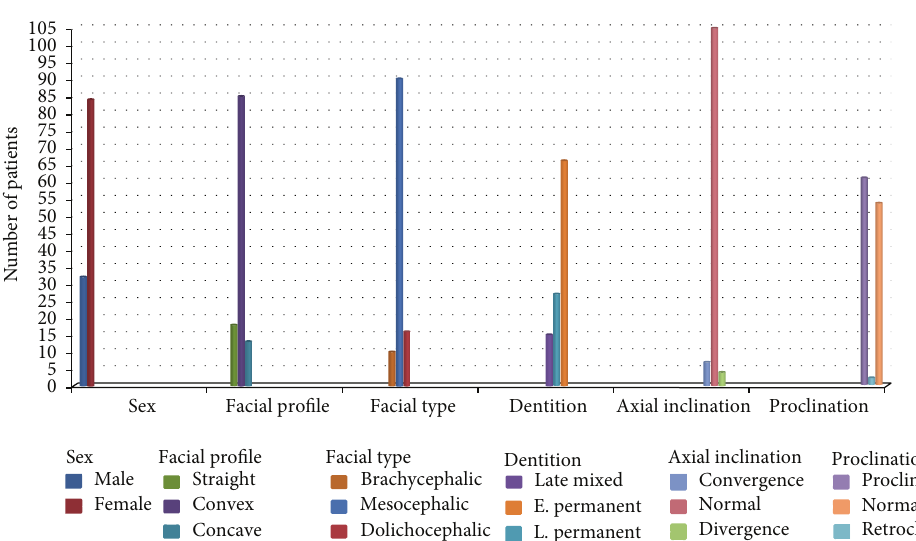
Figure 2: Bar chart showing the distribution of the criteria of the